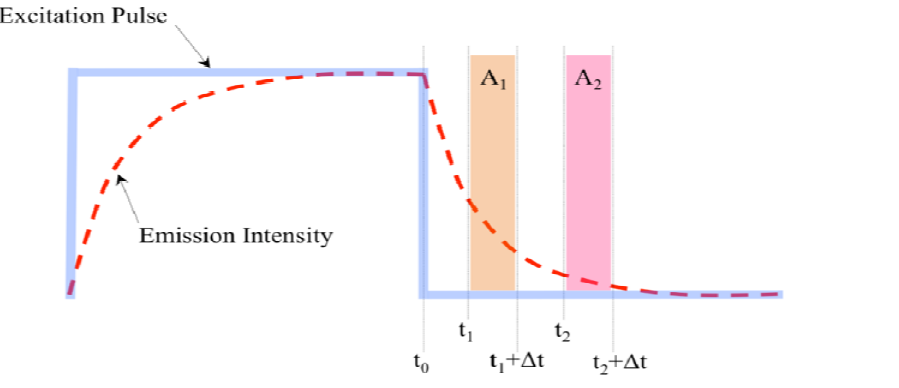
Figure 3. Illustration of “pulse-and-gate” time-domain luminescence lifetime detection. The transparent colored boxes indicate the windows of data acquisition; the decay constant and luminescence lifetime can be determined from the data acquired in these windows (figure adapted from